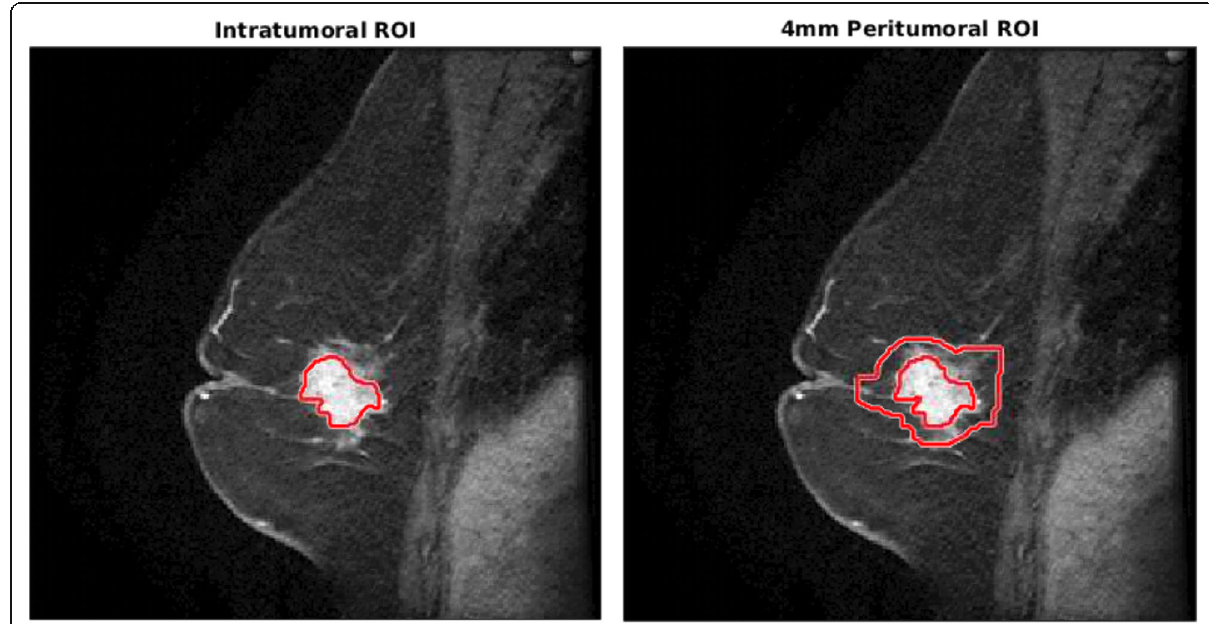
Fig. 3 Representative image of intratumoral ROI and peritumoral ROI. Intratumoral ROI was drawn by a radiologist on the first post-contrast image. The peritumoral ROI was generated by dilating the intratumoral ROI by 4